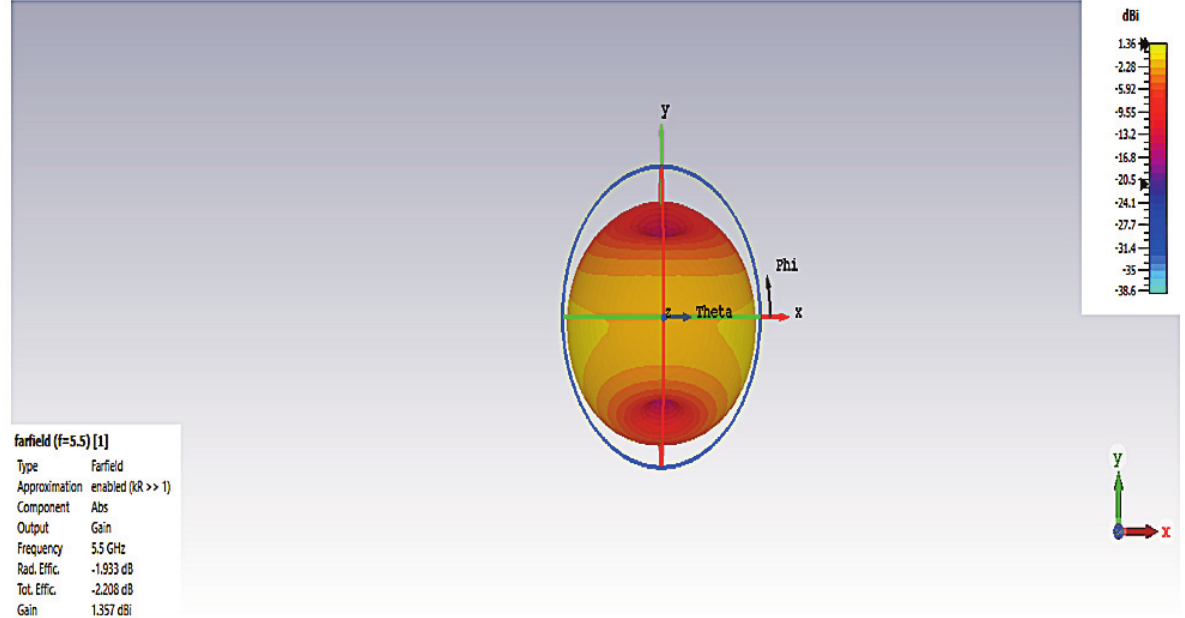
Fig. 6. 3D radiation patterns for the simulated antenna at 5.5